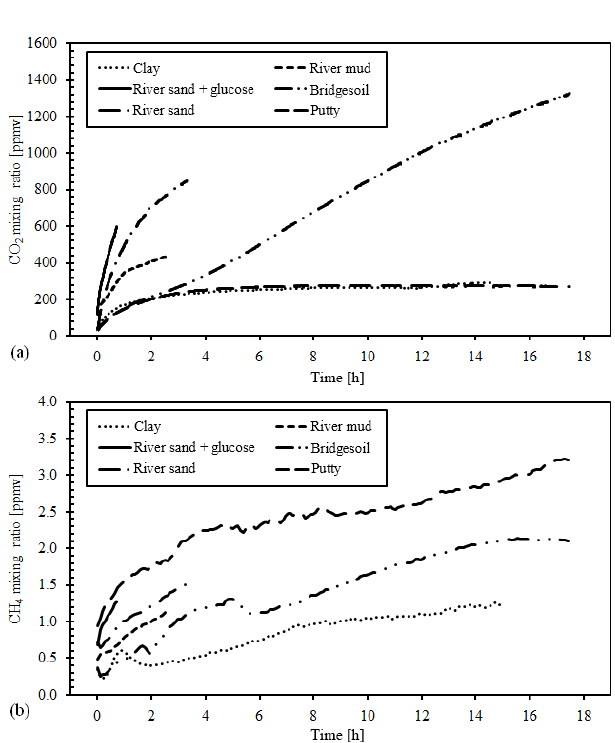
Table 1. Substances tested as sealing materials. Substance Description Clay Potter’s clay River sand Sand collected from the shores of the Elbe (coordinates: 52 ◦ 7 . 92 (cid:48) N, 11 ◦ 39 . 42 (cid:48) E), sieved (2mm) and homog- enized before use. Putty Silly Putty, dilatant compound by DOW CORNING ® based on silicon polymers. River sand + glucose